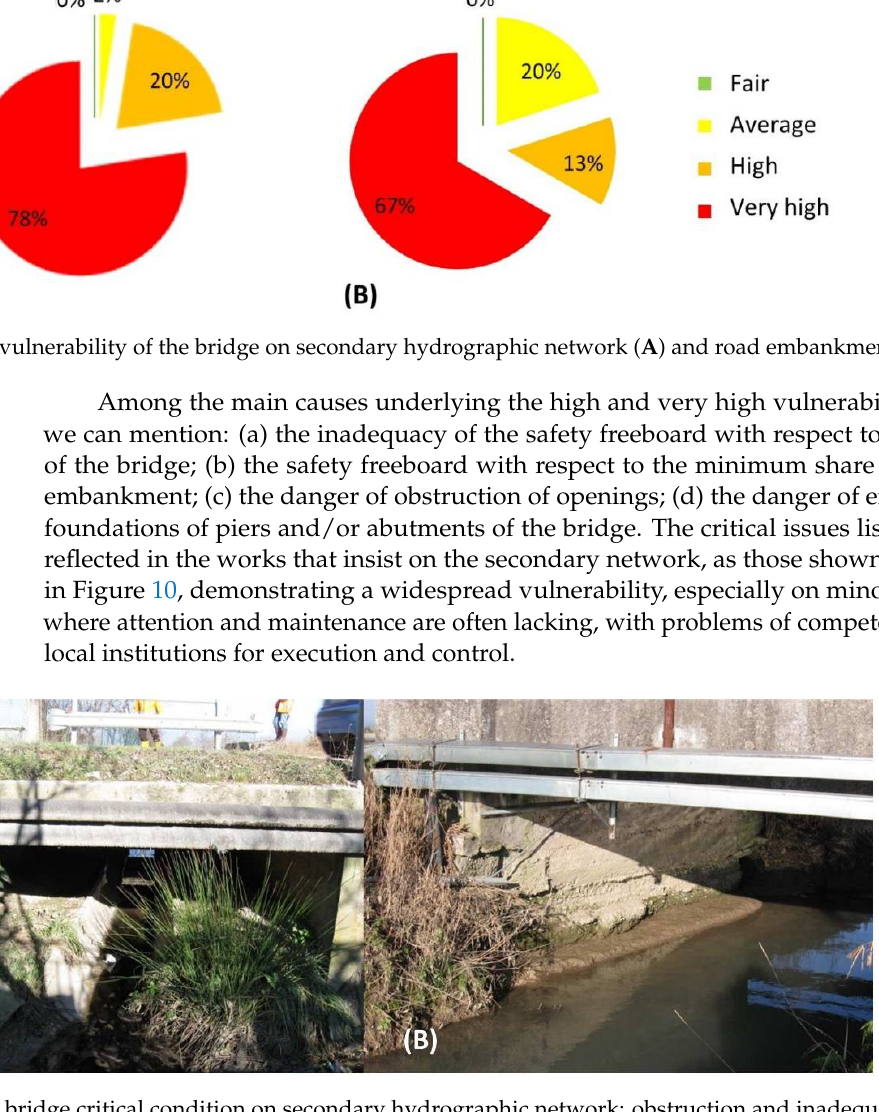
Figure 10. Examples of bridge critical condition on secondary hydrographic network: obstruction and inadequate water section ( A ), scour phenomena ( B ).